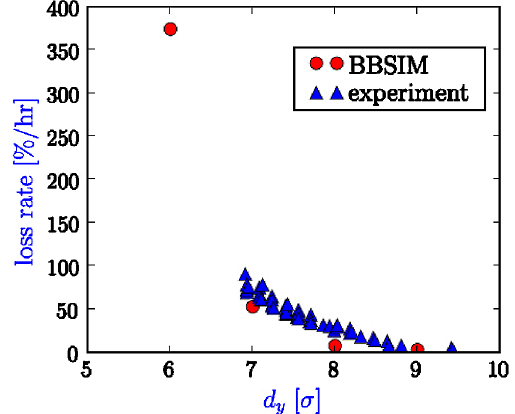
FIG. 15. Comparison of measured and simulated beam loss rate as a function of distance between wire and beam. Experiment with gold beam at store, wire strength of 125 Am [52,54].